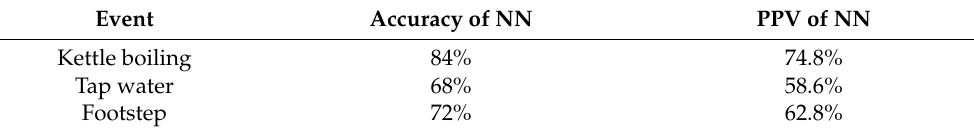
Table 8. The accuracy and PPV values of the NN classifiers with context